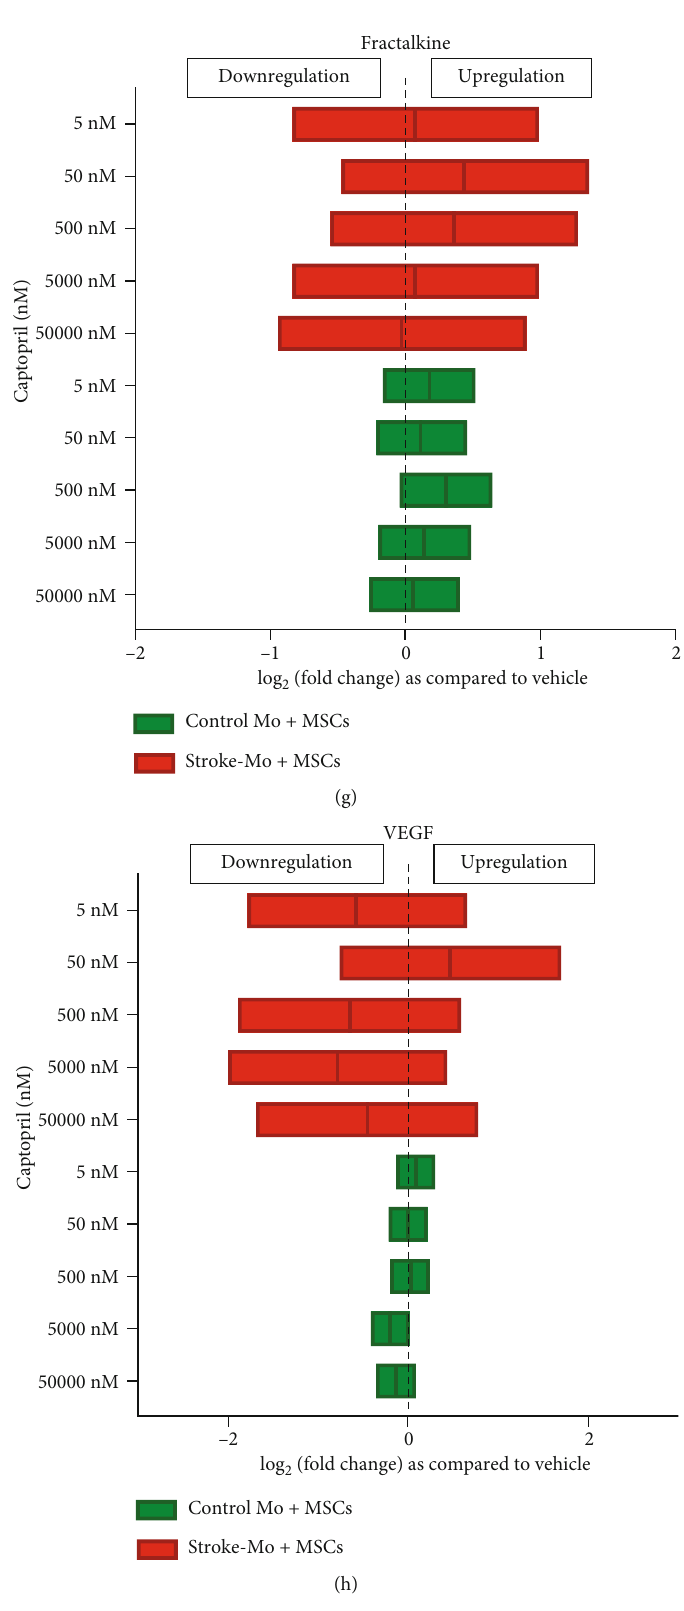
Figure 4: Captopril reduces the cytokine secretions of IL-8, MCP-1, TNF- α , IL-1RA, and IL-6 from cocultures of healthy control monocytes with MSCs after 24 hours but increases only IL-6 secretions from cocultures involving stroke patient-derived monocytes without changing any other cytokine secretions. Signi fi cance is shown by ∗ p < 0 : 05 . All fold changes are as compared to vehicle